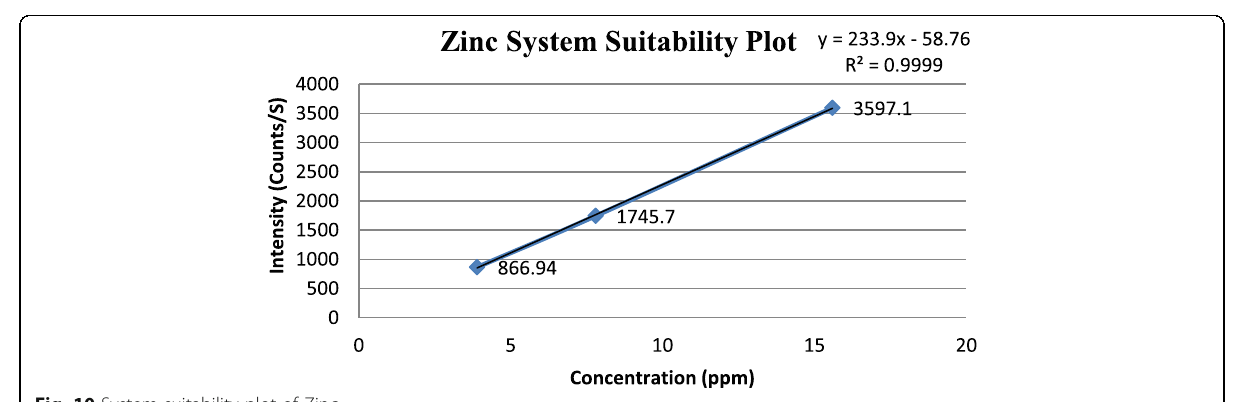
Fig. 10 System suitability plot of Zinc